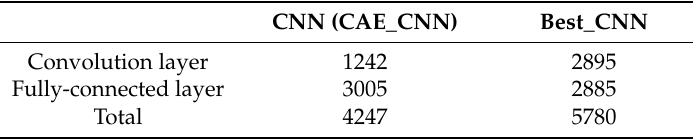
Table 5. The number of parameters of the